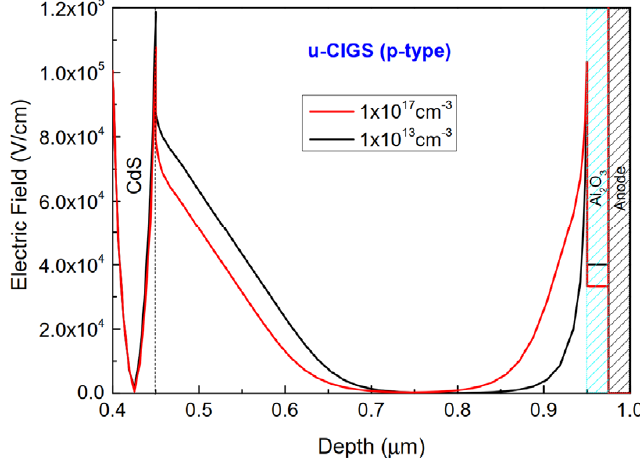
Figure 8. Cell parameters as a dependence of energy level for acceptor trap from 2D simulations for different defect densities.